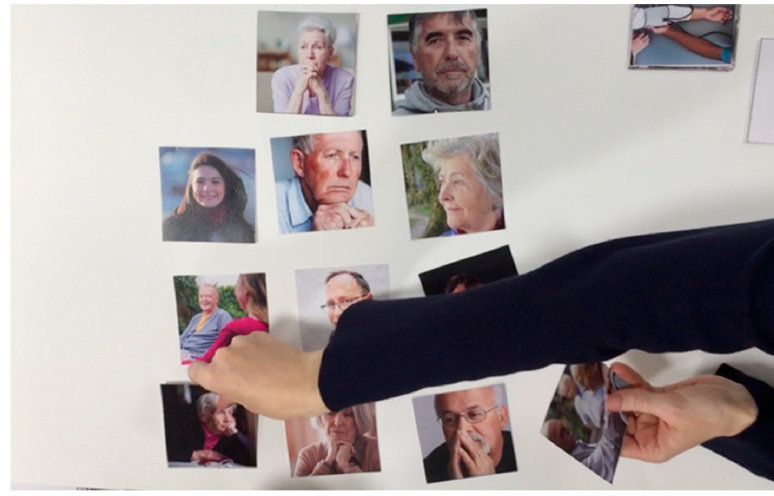
Figure 2. Example of the character cards presented to the Age Workshop participants.